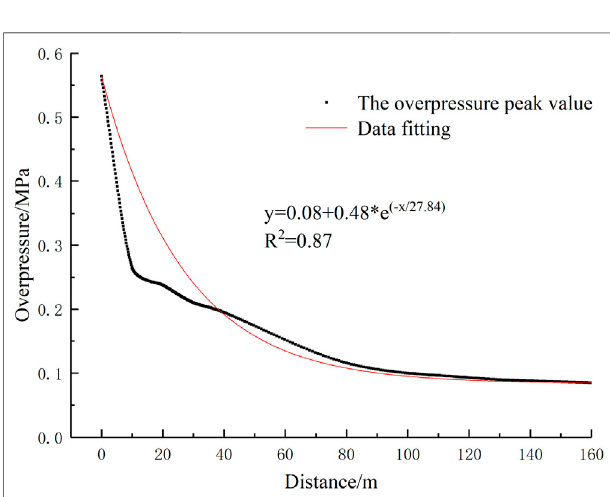
FIGURE 6 | Variation of overpressure peak value with distance in intake airway 1.